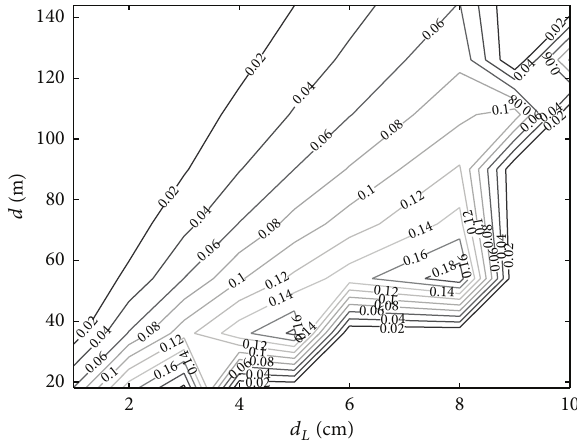
Figure 6: The isosurfaces for transmission when different layer thickness’ and propagation distances were